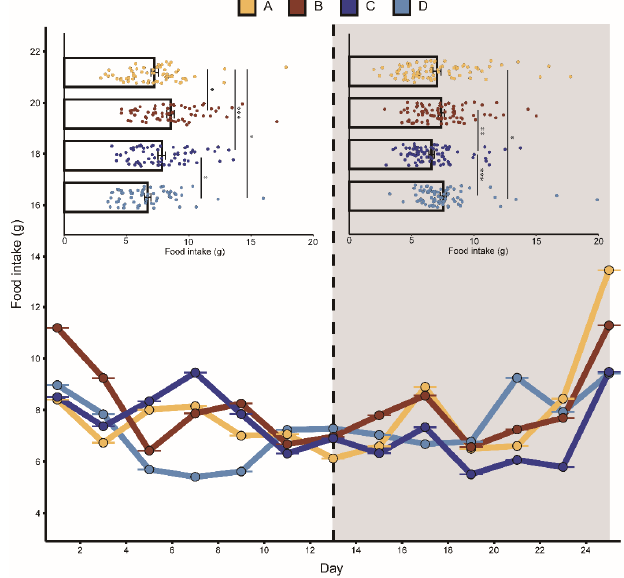
Figure 2. Change in food intake of bats in different groups. The playback period is represented by the dark grey box. A represents the noisy-calls playback group, B represents the tonal-calls playback group, C represents the white-noise playback group, and D represents the control group. The bar chart shows the results of the Kruskal–Wallis test, and the data are presented as mean ± standard error of the mean. * means p < 0.05, ** means p < 0.01, and *** means p < 0.001.